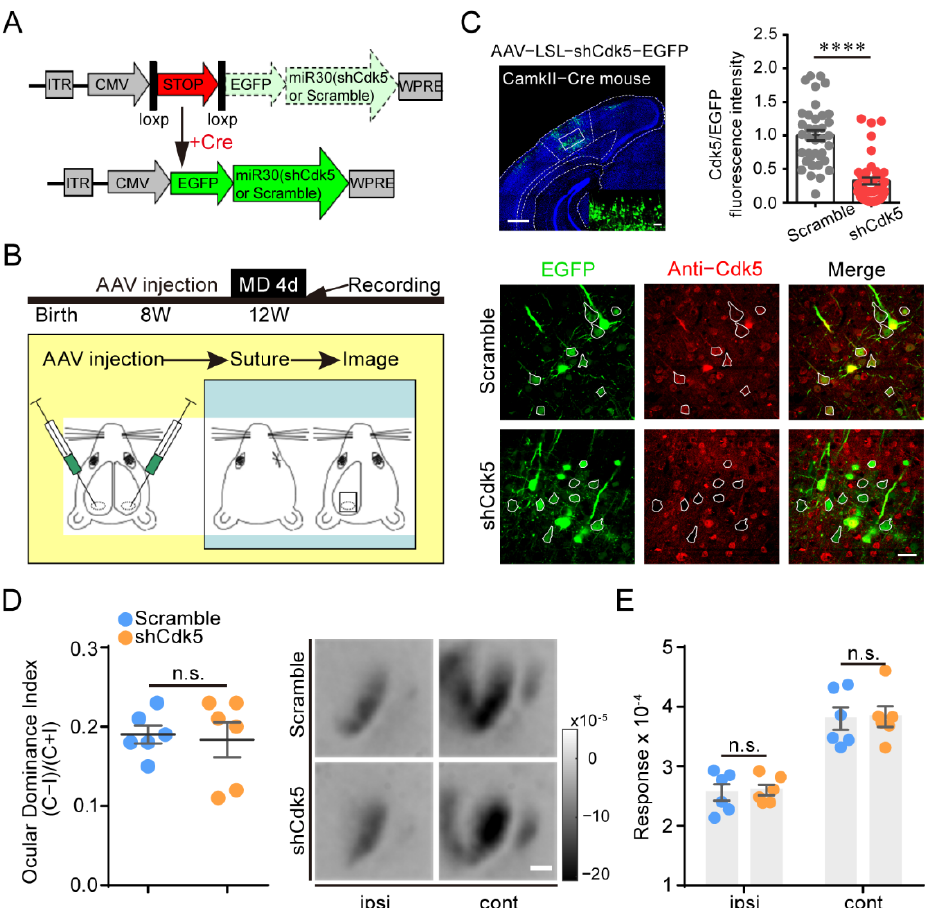
Figure 2. Knockdown of Cdk5 in V1 pyramidal neurons has no effect on adult OD plasticity. ( A ) Scheme for the modification of a miR30 vector (shCdk5 or scramble gene sequence) into an LSL/Cre-controlled version. The conditional miR30 vector can be activated by excision of the stop cassette through Cre-mediated deletion. ( B ) Experimental design. V1L: AAV–shCdk5/scramble; V1R: AAV–scramble. ( C ) Upper left: A representative image of infected pyramidal neurons with AAV–shCdk5. Scale bar, 500 μ m. Enlarged view shown in inset. Scale bar, 50 μ m. Upper right: Cdk5 was quantified by immunofluorescence using Abs against Cdk5 (scramble = 1.00 ± 0.07, n = 37; shCdk5 = 0.32 ± 0.05, n = 42; t = 7.71, p < 0.0001, unpaired t -test). Bottom: IHC in V1 of CaMKII-Cre mice. Virus-infected pyramidal neurons (green) and Cdk5 immunoreactivity (red). Virus-infected pyramidal neurons are enclosed by white hollow circles. Scale bar, 30 μ m. ( D ) Left: Comparison of ODI measured from CaMKII-Cre mice injected with AAV–scramble (blue) and AAV–shCdk5 (orange) after 4d MD (t = 0.27, p = 0.79, unpaired t -test). Right: Example intrinsic signal images from CaMKII-Cre mice injected with AAV–scramble and AAV–shCdk5 after MD. Scale bar, 500 μ m. ( E ) Comparison of response magnitude of intrinsic optical signals elicited by stimulating the ipsilateral eye or contralateral eye for AAV–scramble- or AAV–shCdk5-injected CaMKII-Cre mice following 4d MD (F(1, 20) = 0.06, p > 0.05, two-way ANOVA with Tukey’s post hoc test). ODI: ocular dominance index; MD: monocular deprivation; ipsi: ipsilateral eye; cont: contralateral eye. Data shown as mean ± SEM. n.s., not statistically significant, **** p < 0.0001.